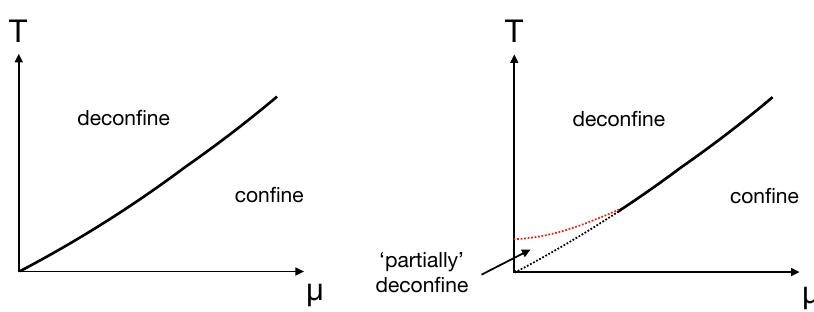
Figure 4. Two kinds of conjectured phase diagrams of the BMN matrix model. The large- µ region permits perturbative calculations [40, 41], and the transition is found to be of first order. The small- µ region has been studied by using the dual gravity description [39] but the order of the transition has not been established. We will argue that the left panel (first-order scenario) is likely to be